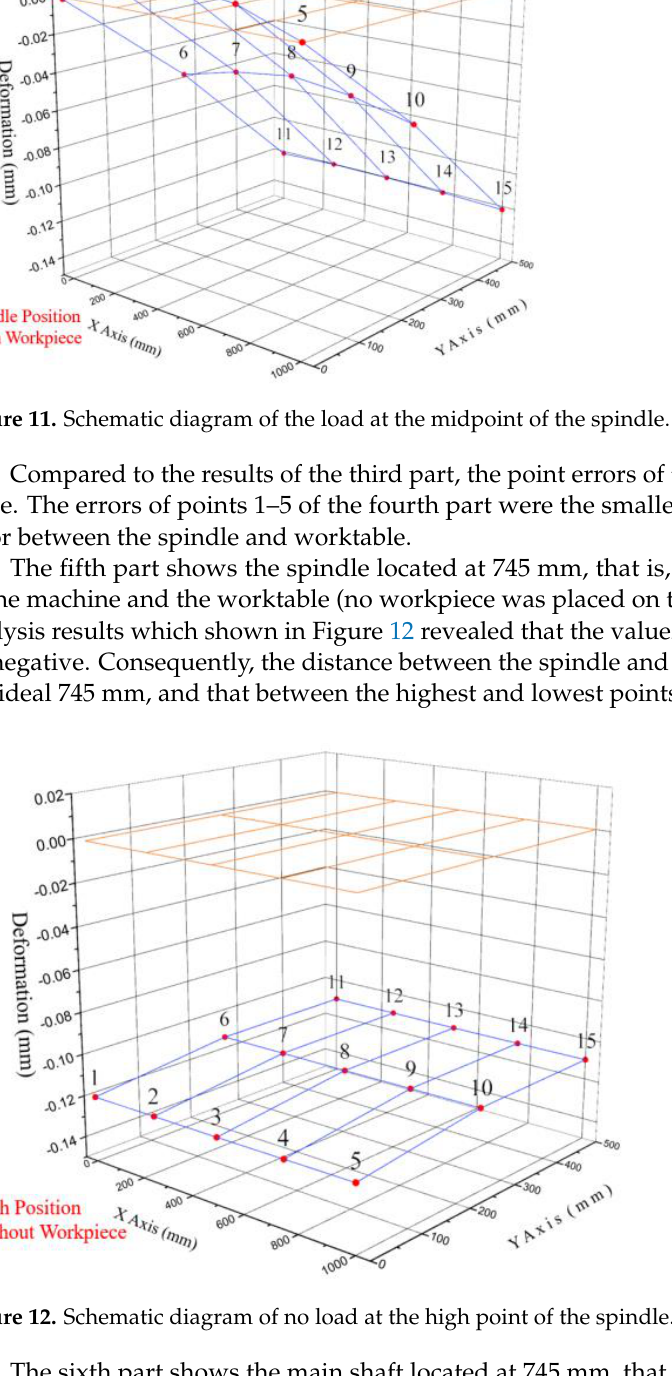
Figure 10. Schematic diagram of no load at the midpoint of the spindle.